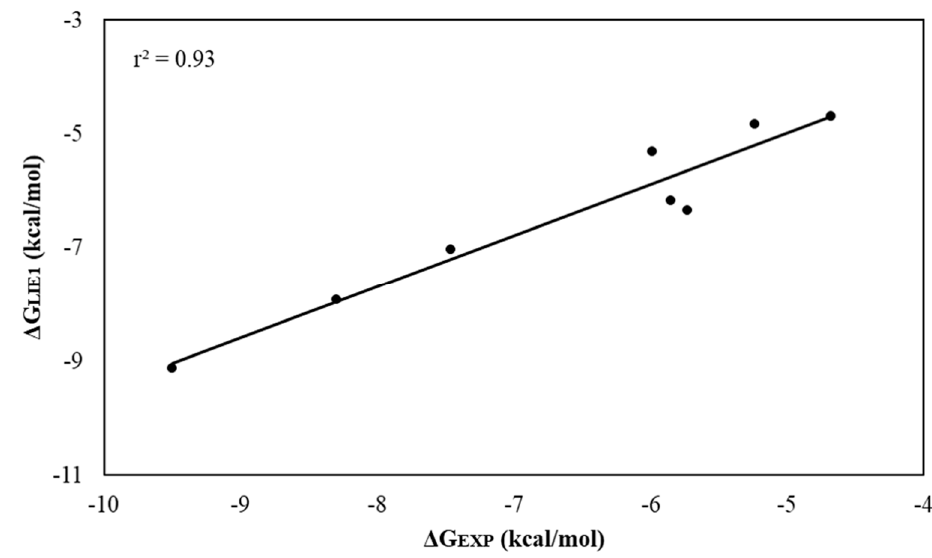
Figure 8. Linear regression graph between Δ G LIE1 and Δ G EXP . Values in kcal/mol.